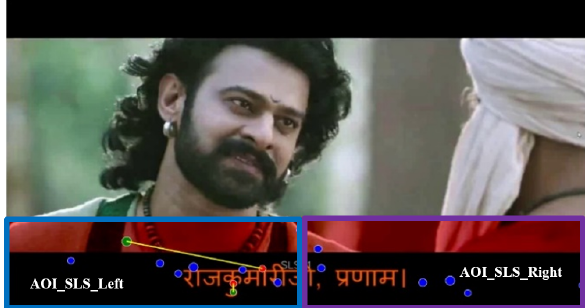
Figure 10: Fixations at AOI_SLS (left/right) of a functional